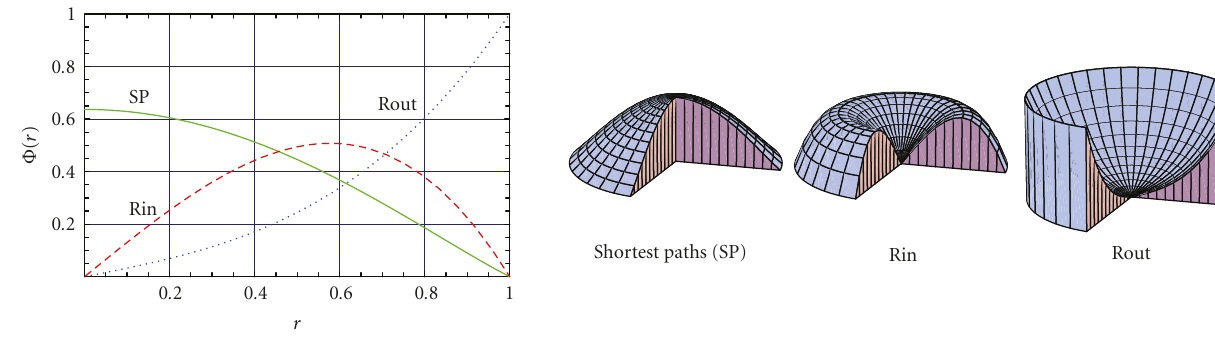
Figure 5: In the graph on left the resulting flux is plotted as a function of distance r from the center for the three path sets (SP, Rin, and Rout) in unit disk ( Λ = 1). The 3D graphs on the right illustrate the same situation.